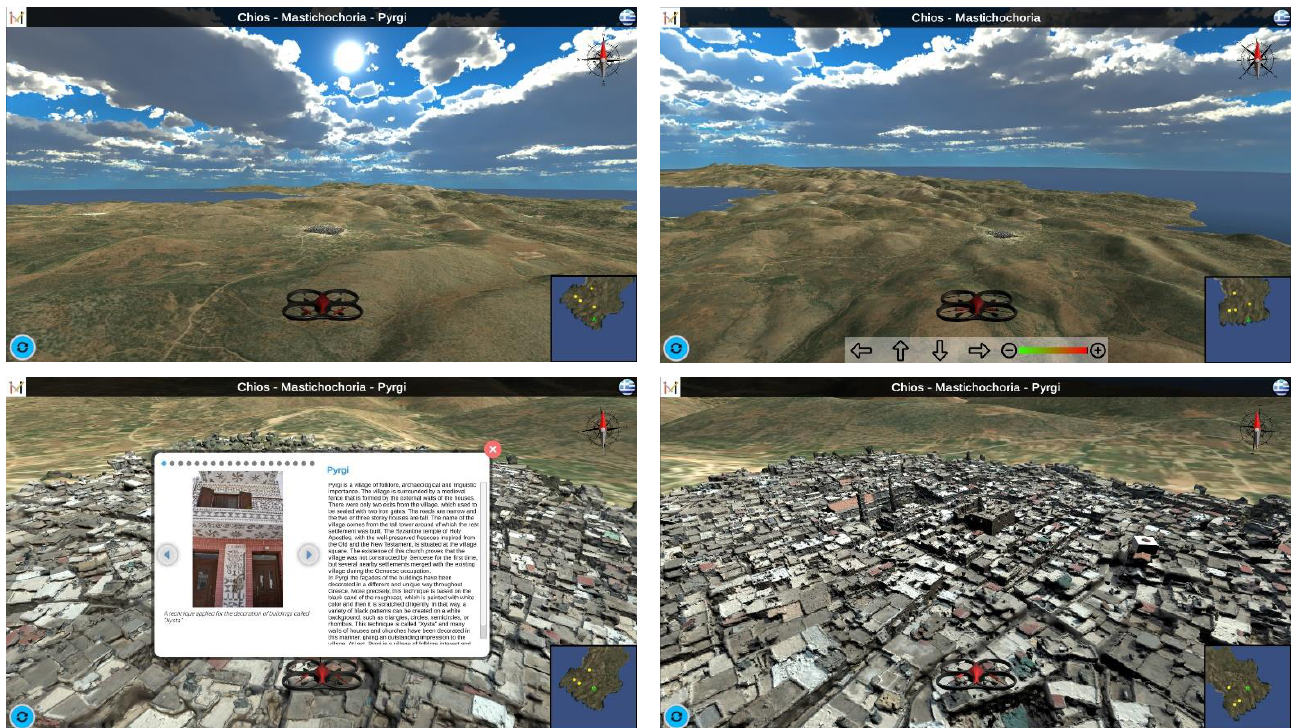
Figure 18. Chios airborne.